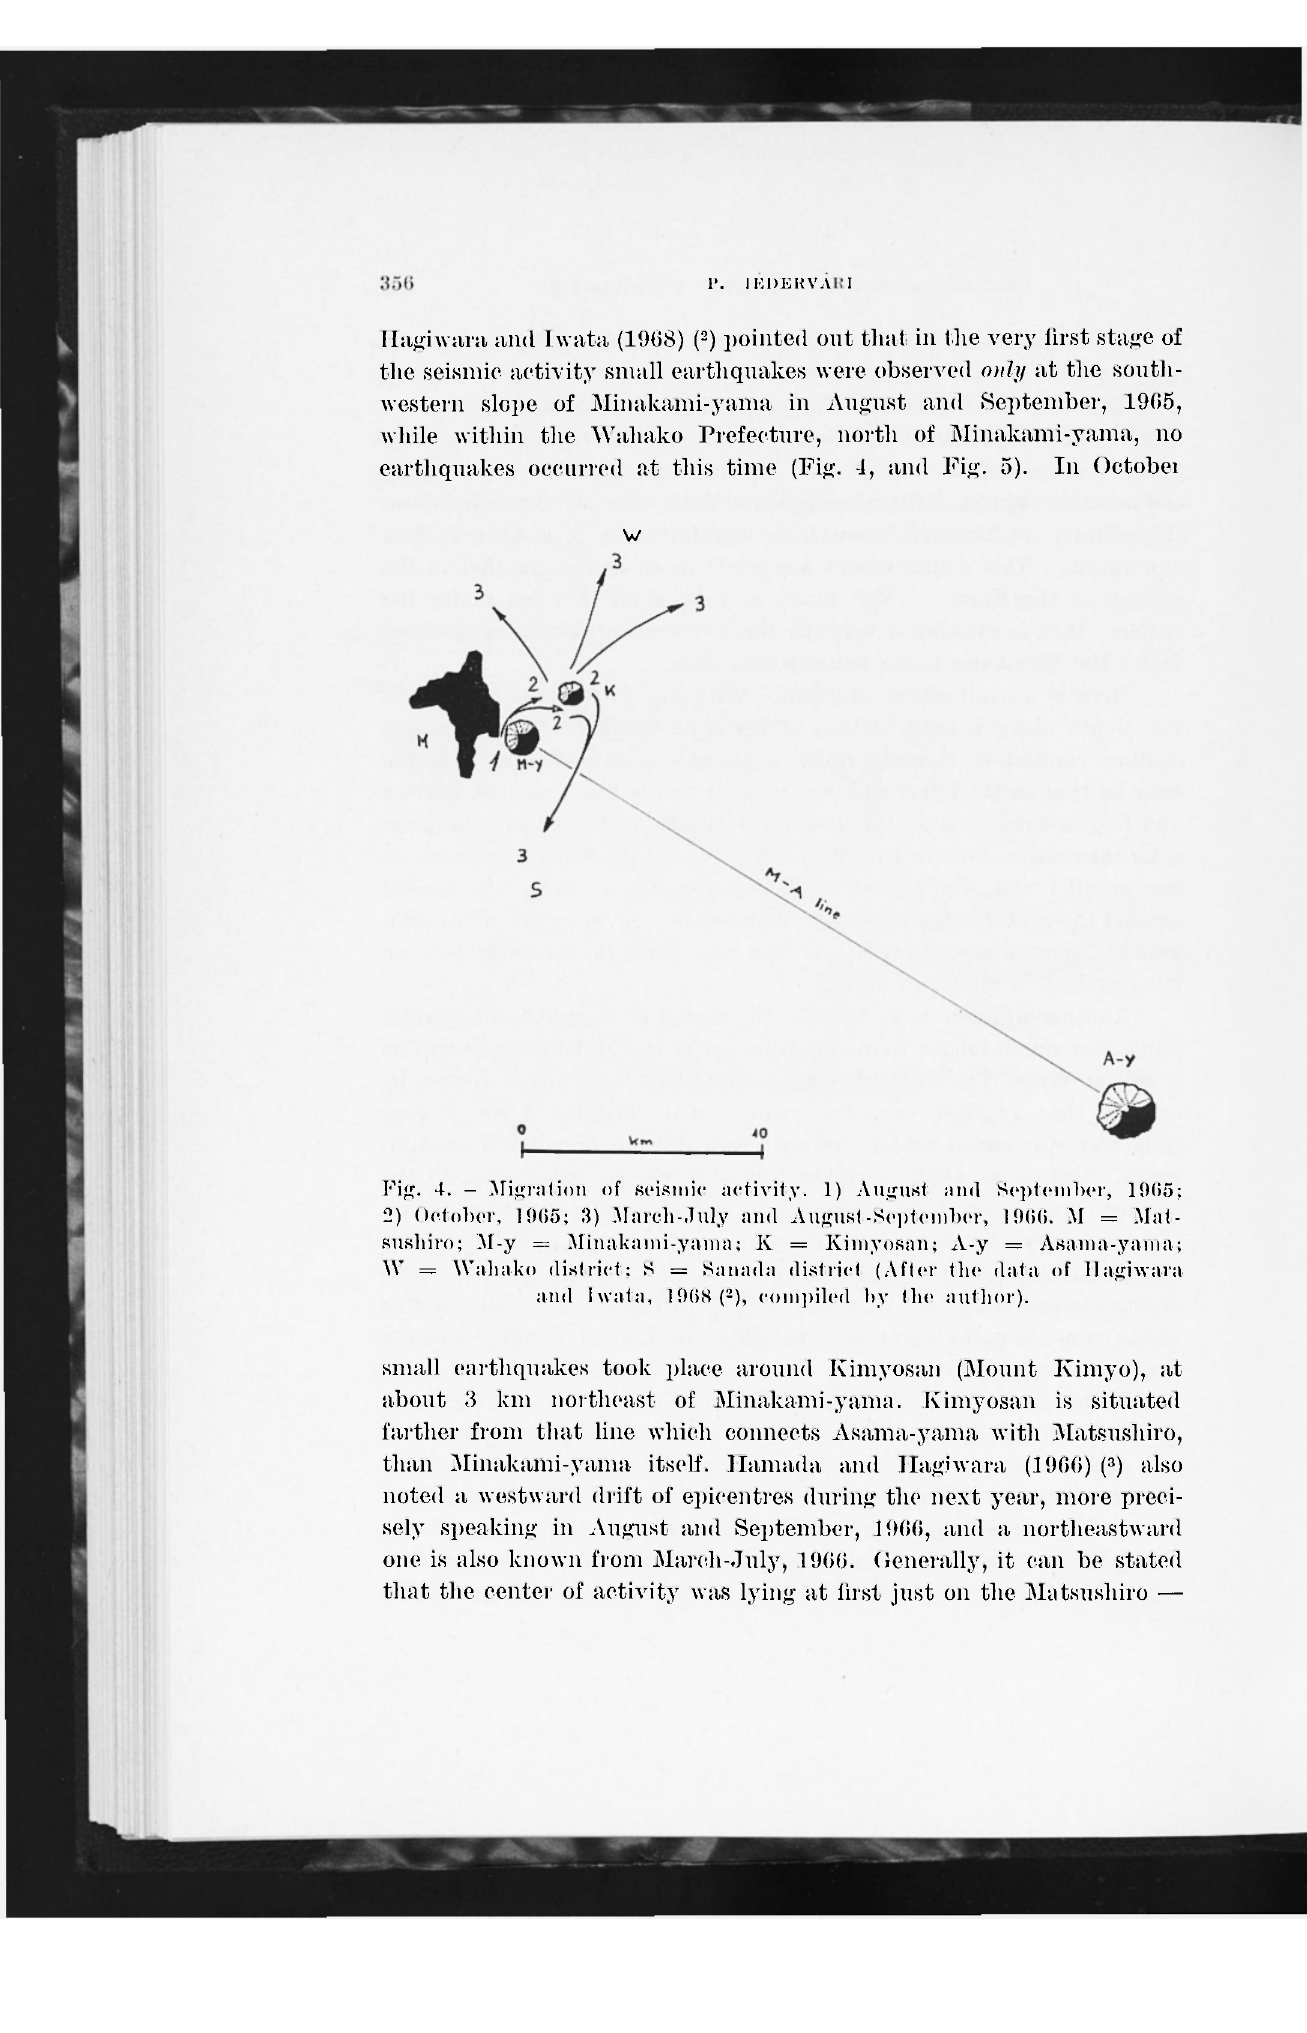
Fig. 4. - Migration of seismic activity. 1) August and September,